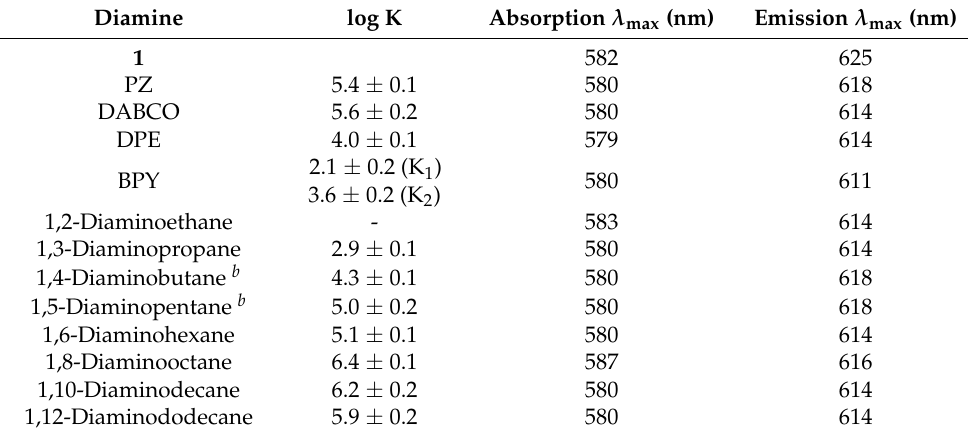
a For comparison, 1 · (pyridine) 2 ; λ max = 579 nm (absorption); λ max = 613 nm (emission); log K 1 = 2.35; log K 2 = 3.58; from ref. [45]. b from ref. [46].